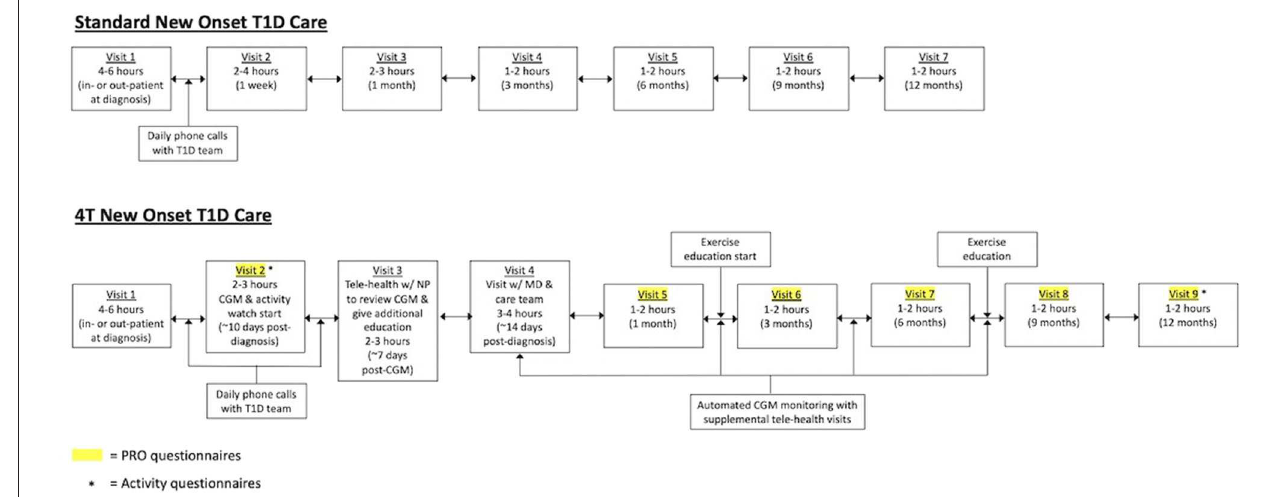
FIGURE 1 | Standard new-onset type 1 diabetes (T1D) care compared with the 4T new-onset T1D program.